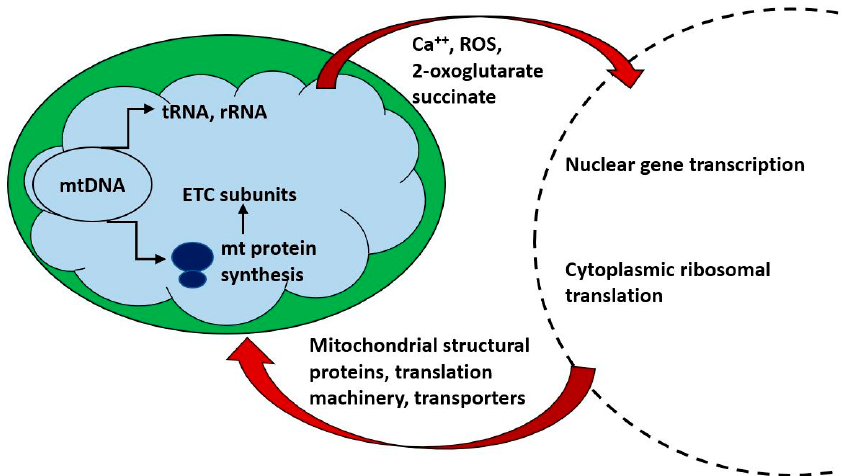
Figure 2. Mitochondria communicate bidirectionally with the nucleus and cytoplasm. Nuclear gene transcription is required for the synthesis of the vast majority of mitochondrial components, is tightly coordinated with mitochondrial protein synthesis and is responsive to the energetic requirements of the cell. Small metabolites (e.g., 2-oxoglutarate and succinate) act as ligands for G protein coupled receptors which may in turn affect cellular metabolism and nuclear gene transcription.